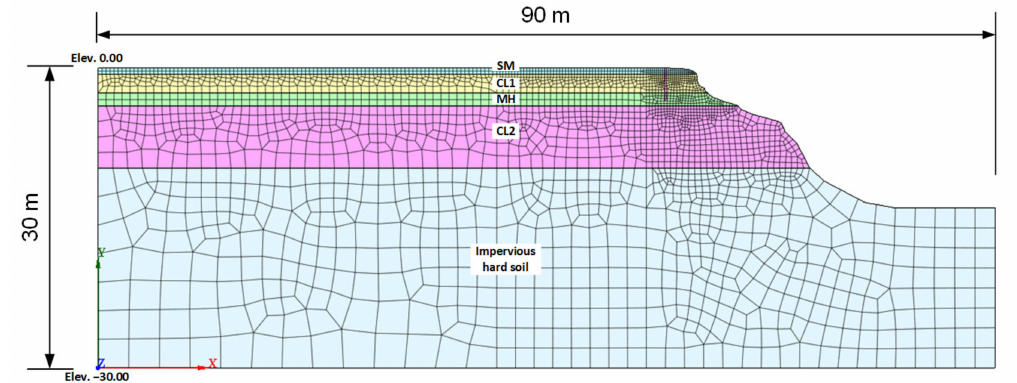
Figure 7. Bank geometry and finite element mesh for the transient seepage analysis.